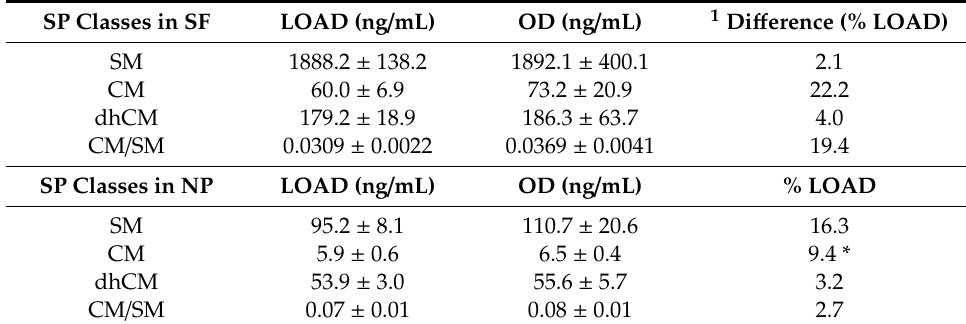
Table 4. Sphingolipids (SP) in supernatant fluid (SF) and nanoparticle (NP) of late-onset Alzheimer’s disease (LOAD) and other dementia